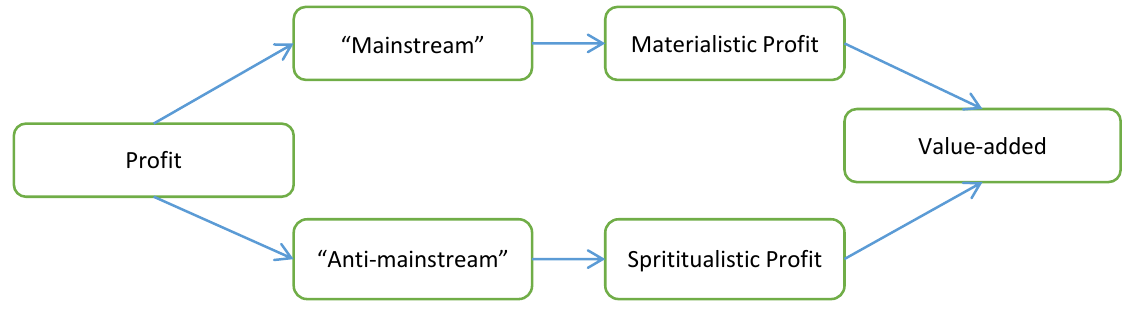
Figure 1. Understanding the meaning of profit at the semantic